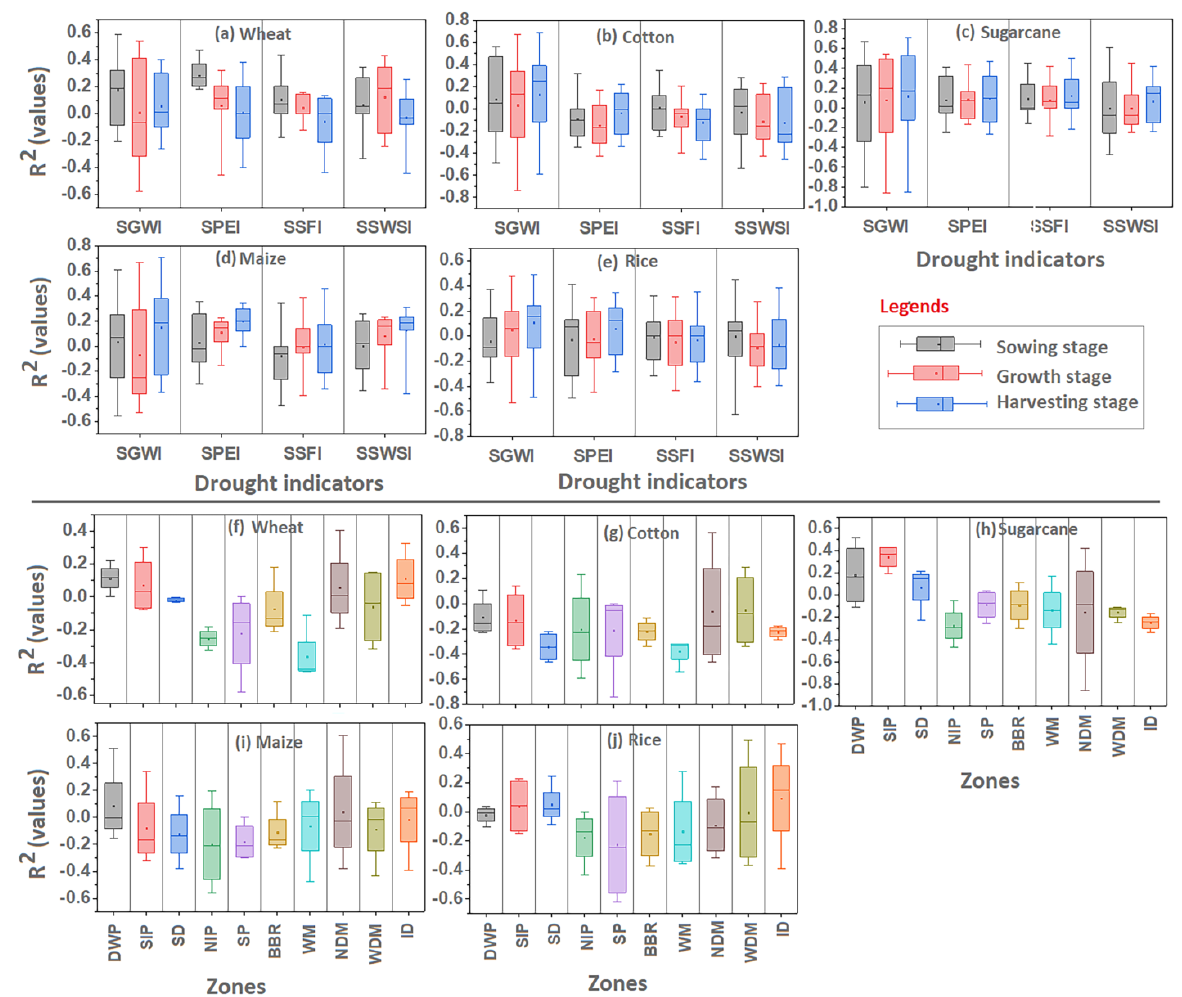
Figure 10. ( a – e ) Box plot (minimum – maximum) values of the correlation coefficient between drought indicators and SYRI in different crop growth stages, and ( f – j ) average correlation between SYRI and combined drought indicators across different AEZs from 1981 – 2017.